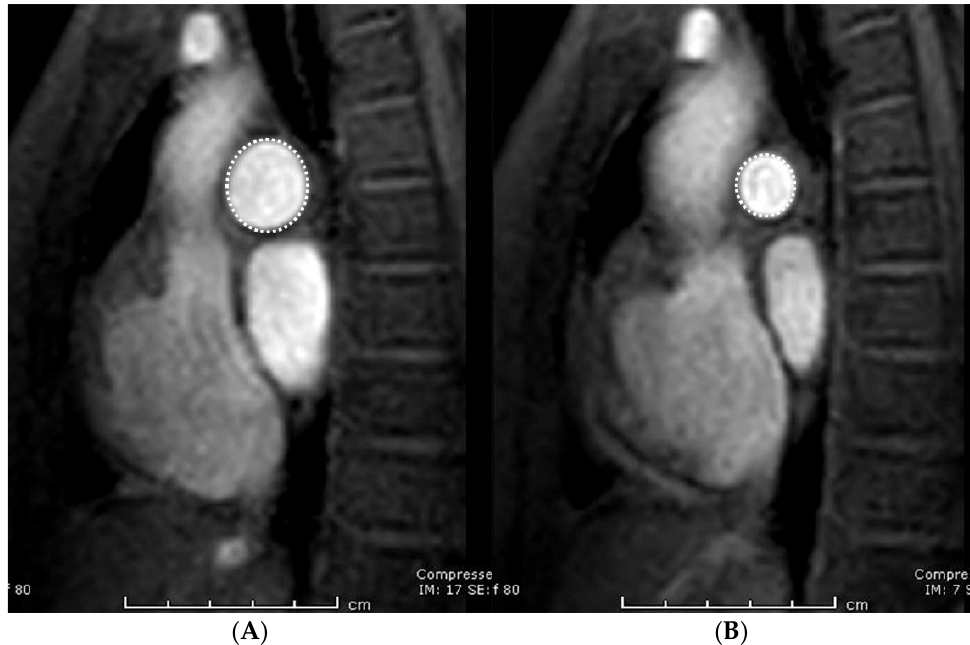
Figure 3. Phase-contrast magnetic resonance imaging of the pulmonary artery demonstrates the measurement of maximum area ( A ) and minimum area ( B ).